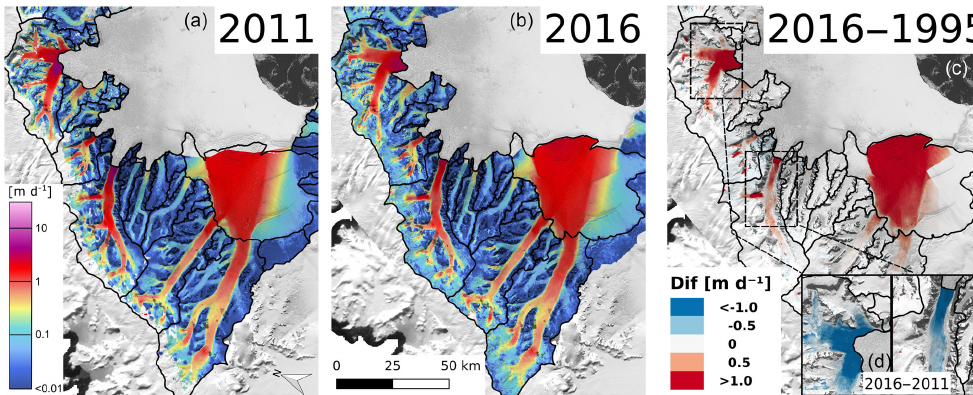
Figure 9. Magnitude of ice velocity (md − 1 ) in 2011 (a) and 2016 (b) derived from TerraSAR-X and TanDEM-X data. Gaps in 2011 are filled with PALSAR data and in 2016 they are filled with Sentinel-1 data. (c) Map of velocity difference between 2016 and 1995. Insets: velocity difference between 2016 and 2011 for HG and Crane glaciers.